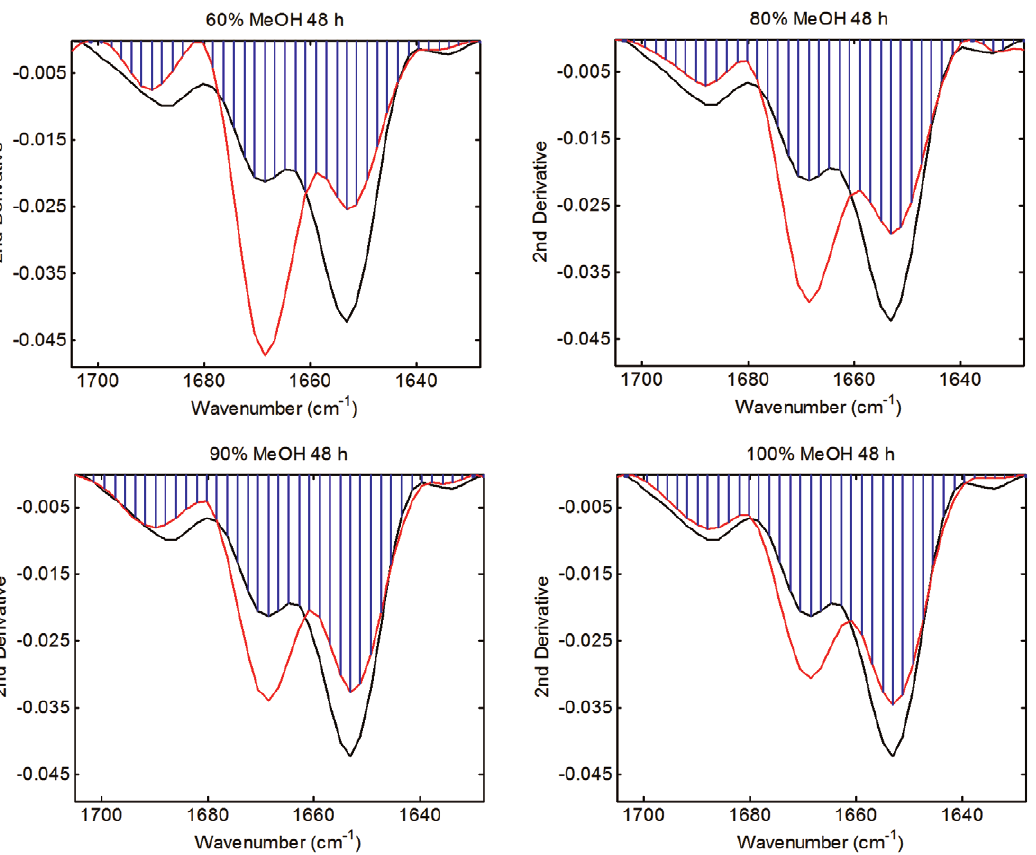
Figure 2. Amide I 2 nd derivative band overlap analysis of honeybee sponges treated with aqueous solutions of 60, 80 or 90 methanol or 100% methanol for 48 hours. Untreated sponge (black trace), treated sponge (red trace) and overlap area (blue shading).